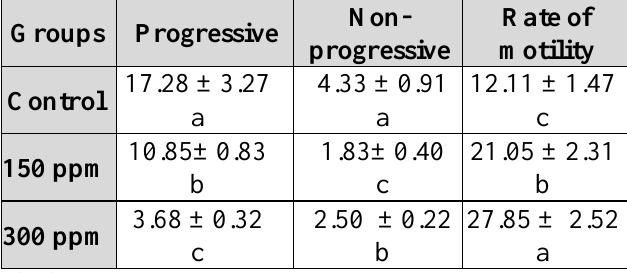
Table 2. Effects of different sub lethal concentrations of sodium fluoride given with drinking water on rates of motility of sperm, mean ± SE.